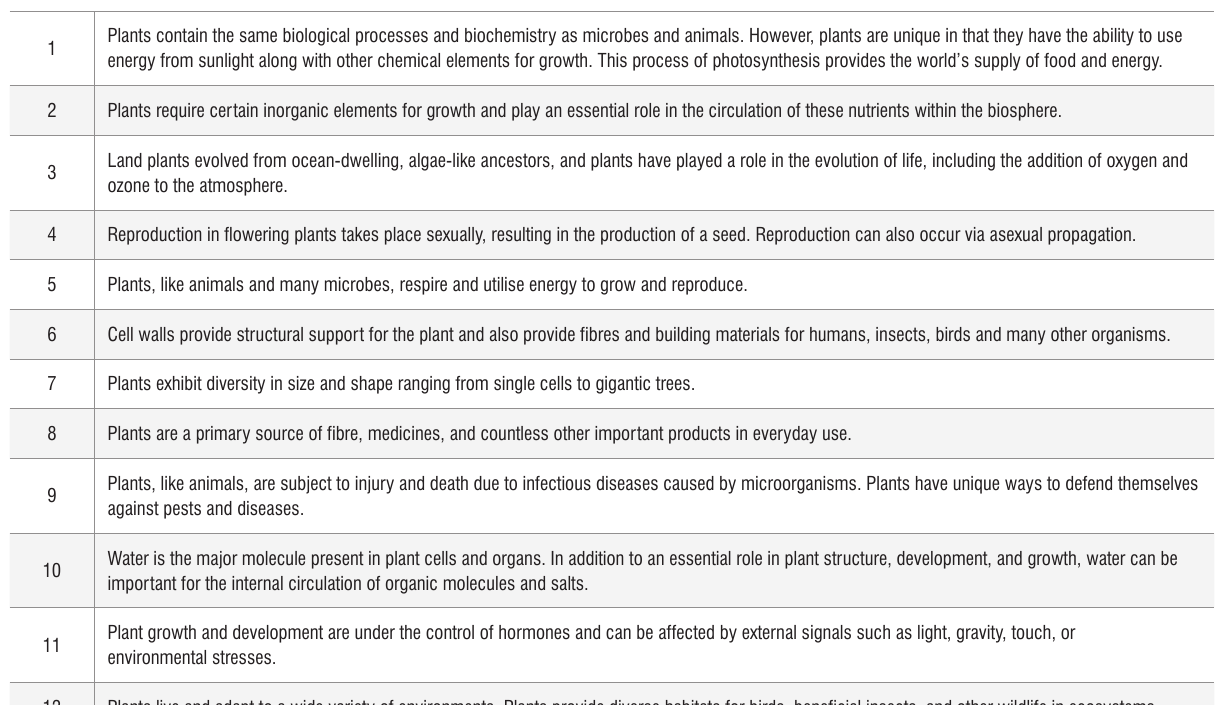
The principles of plant biology developed by the American Society of Plant Biologists.